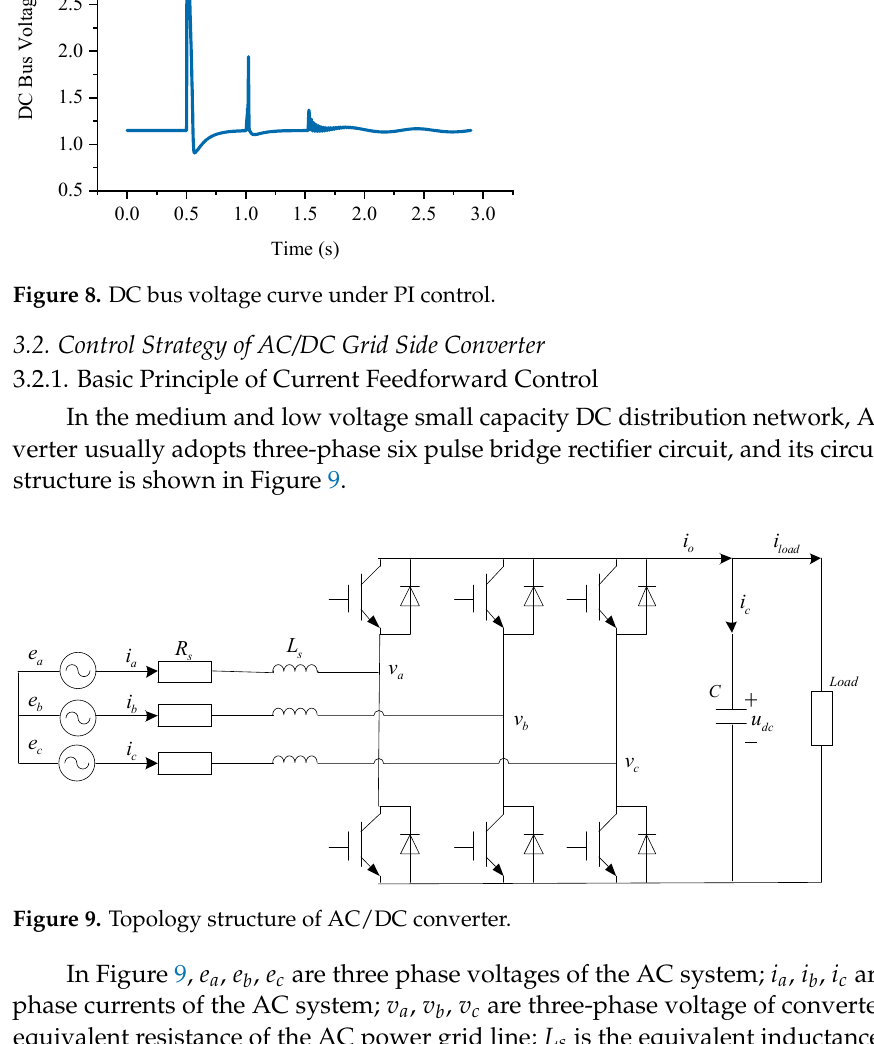
Figure 9. Topology structure of AC/DC converter. In Figure 9, e a , e b , e c are three phase voltages of the AC system; i a , i b , i c are the three phase currents of the AC system; v a , v b , v c are three-phase voltage of converter; R s is the equivalent resistance of the AC power grid line; L s is the equivalent inductance of the AC power grid line; C is a capacitor connected on the DC system side to the filter; u dc is the bus voltage of the DC system. load is the load of the DC grid. The traditional AC/DC grid side converter adopts double closed-loop control strat- egy of the voltage outer loop and current inner loop, and its control block diagram is shown in Figure 10.